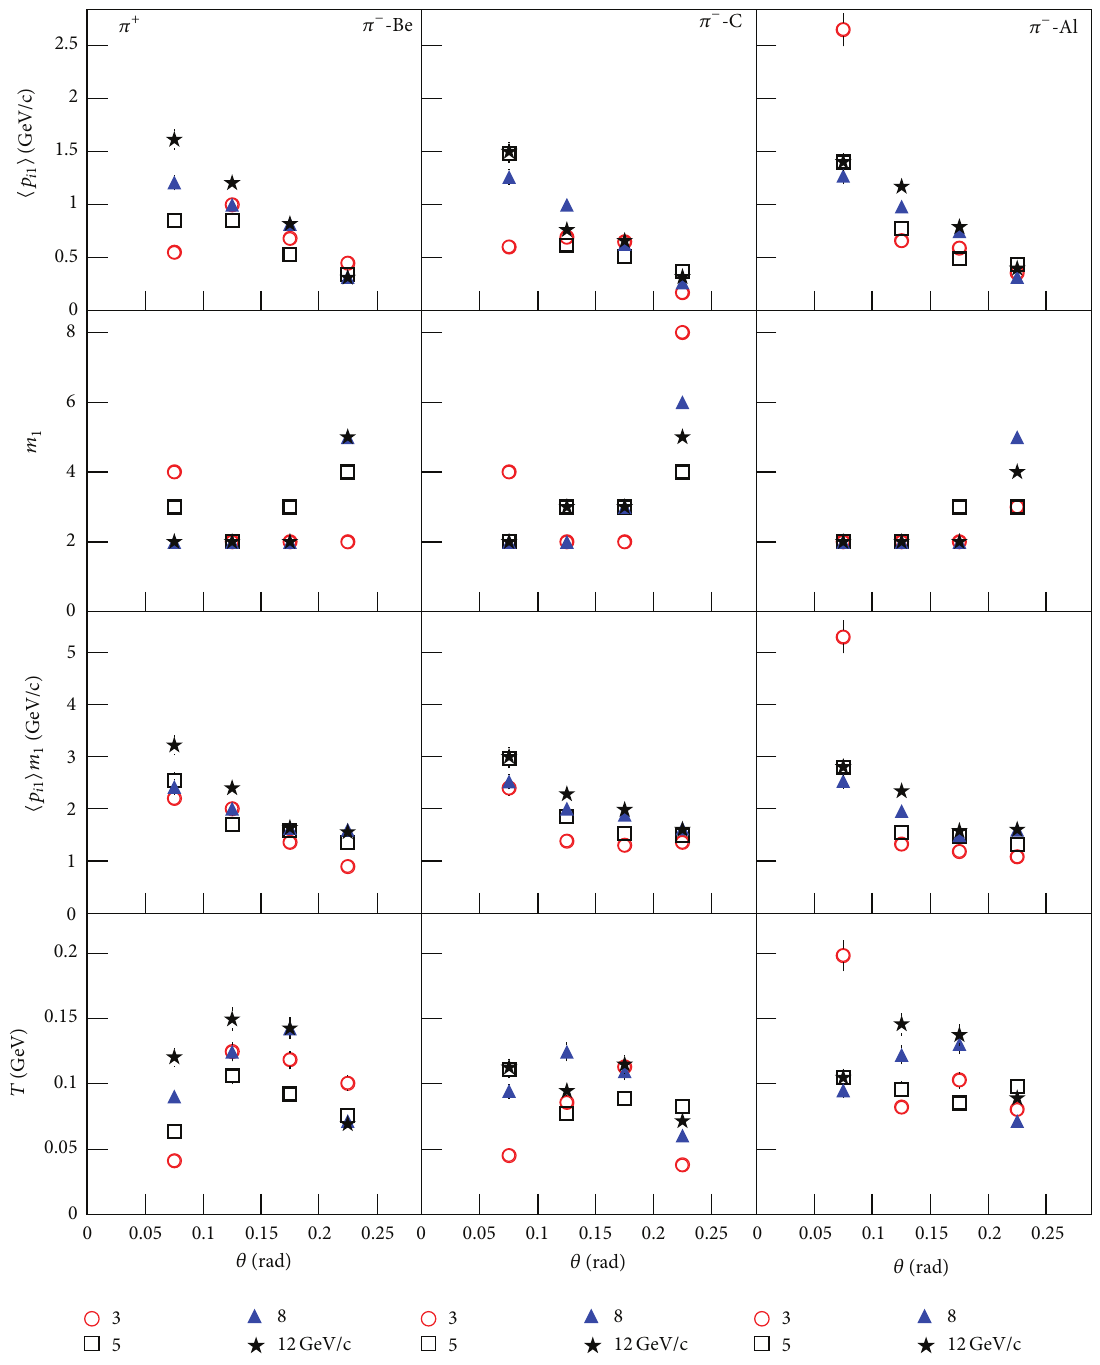
Figure 13: Dependences of ⟨𝑝 𝑖1 ⟩ , 𝑚 1 , ⟨𝑝 𝑖1 ⟩𝑚 1 , and 𝑇 on 𝜃 for 𝜋 + produced in 𝜋 − -Be, C, and Al interactions. The different symbols represent the parameter values obtained at different momentums. The parameter values for targets Be, C, and Al are taken from Figures 1, 5, and 9,